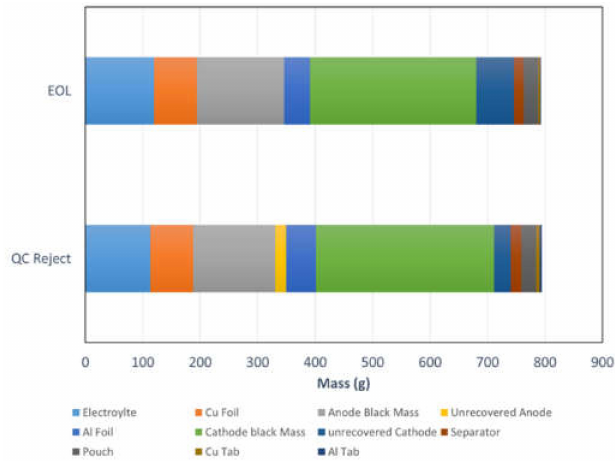
Figure 3. ( a ) Photograph of a module of an end of life (EoL) battery, straight after the casing is opened. ( b ) Photograph of the open module, showing the pouch cells inside. ( c ) Photograph of an individual Quality Control (QC) reject pouch cell. ( d ) Photograph of an open cell pouch, showing the layers of electrode materials